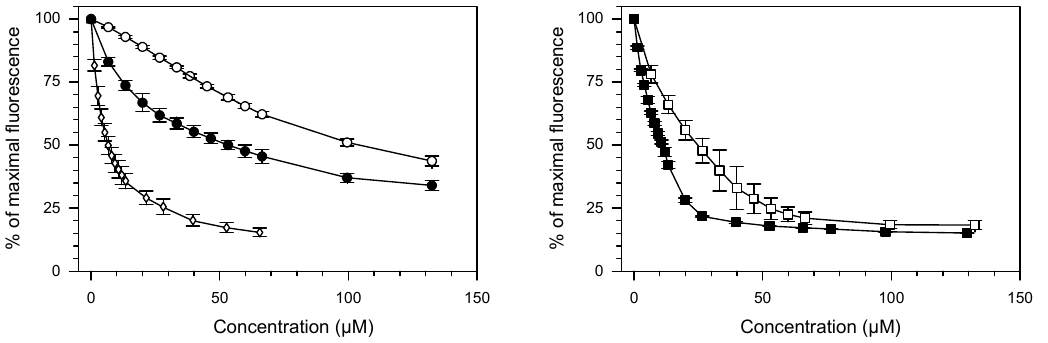
Figure 2. Ethidium bromide (EtBr) displacement assay. Changes of EtBr-calf thymus DNA complex fluorescence observed after the addition of increasing amounts of tested compounds are displayed. ( ● ) 1a ; ( ○ ) 1b ; ( ◊ ) 9-aminoacridine ( 9AA ); ( ■ ) 2a ; ( □ ) 2b . Points represent means of three experiments ± Standard deviation (S.D).